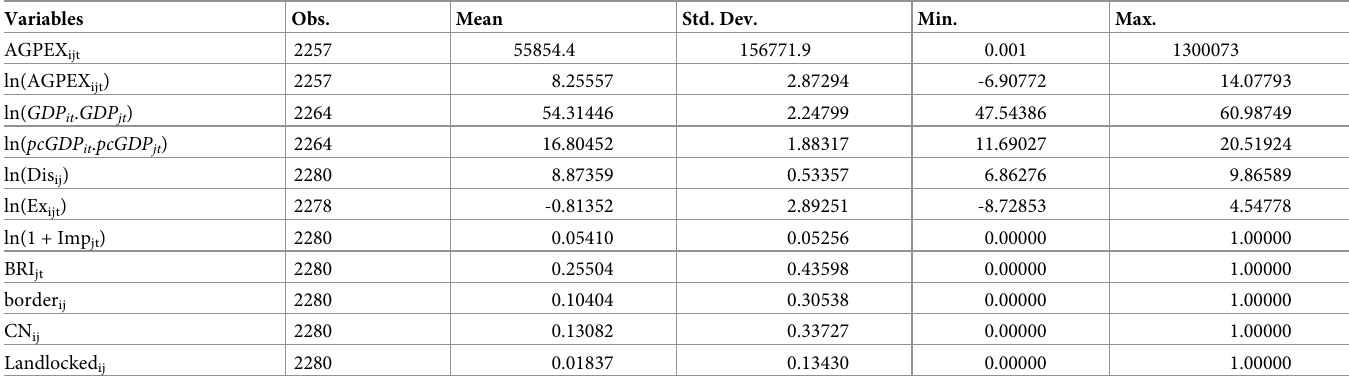
Table 3. Descriptive statistics of the variables. Variables